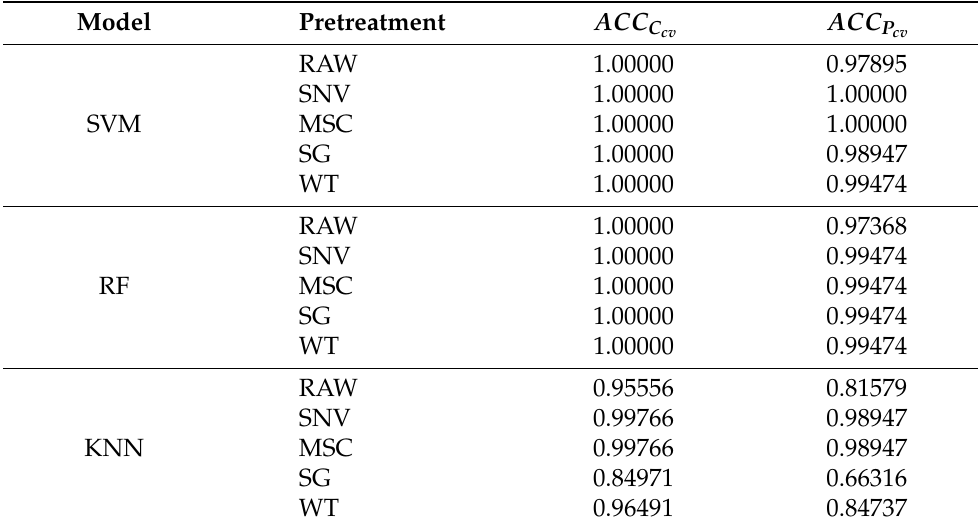
Table 1. The prediction accuracy of oil adulteration types in different